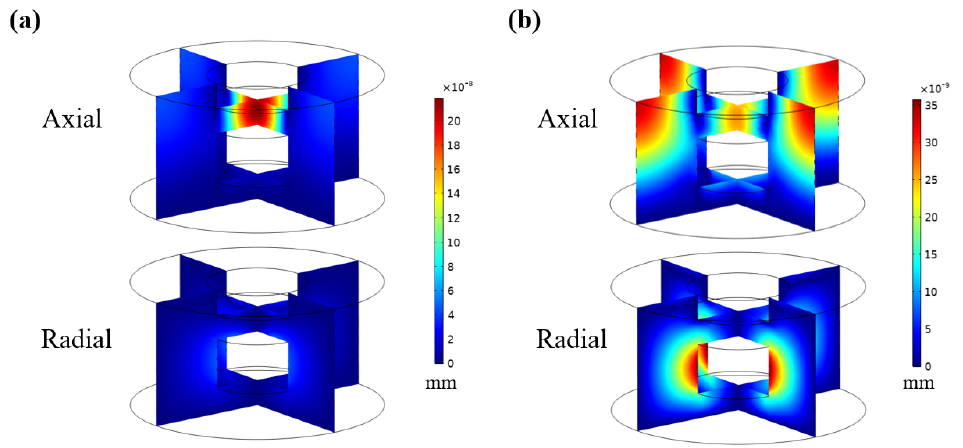
Figure 13. Axial and radial displacement distributions for the hybrid sound-absorbing metastruc- ture at ( a ) 3.1 and ( b ) 5.5